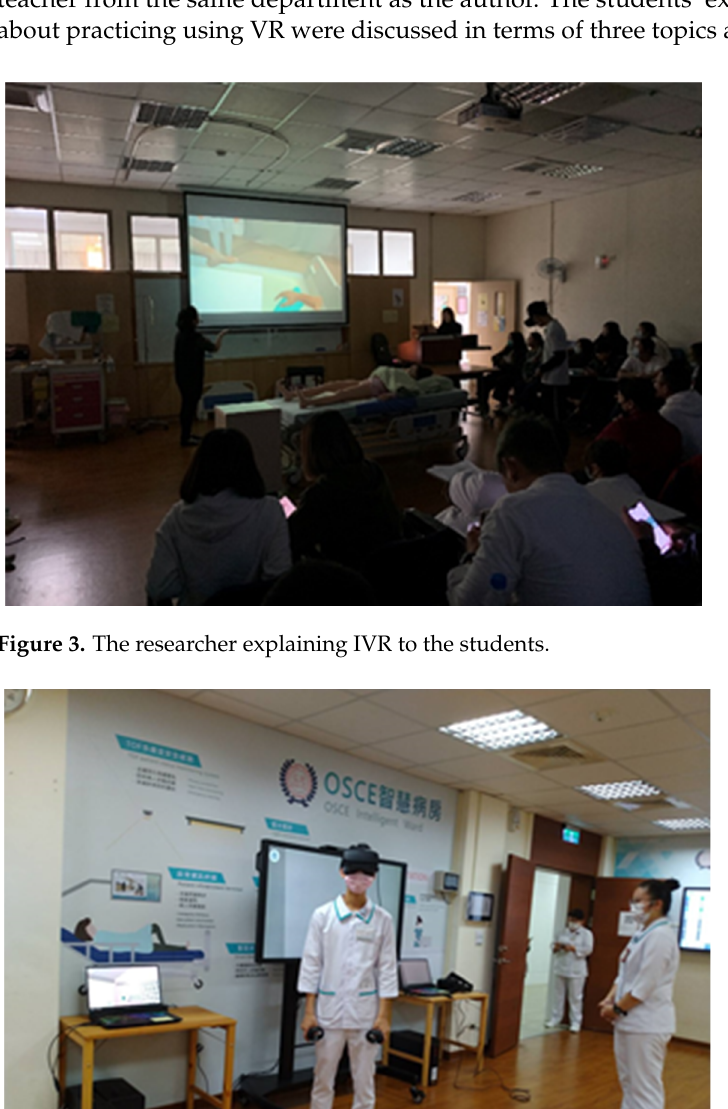
Figure 2. The participant’s viewpoint.